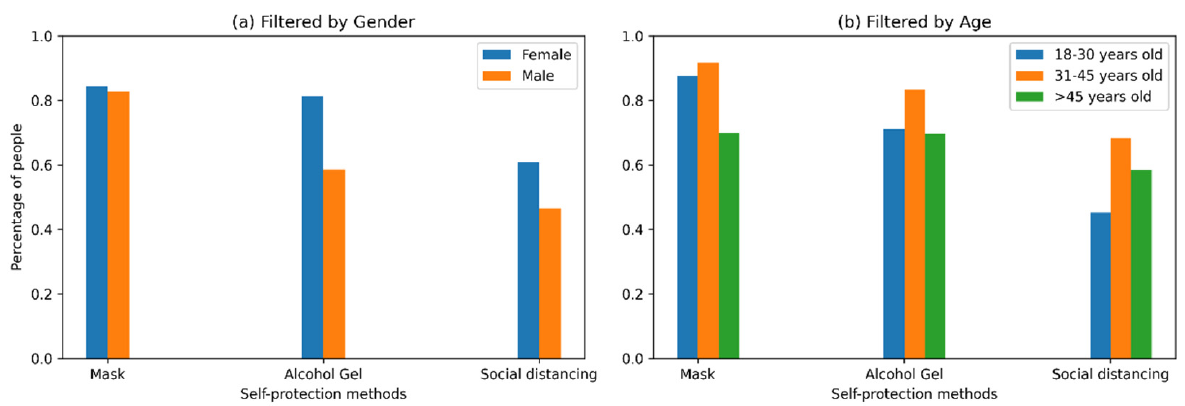
Figure 8. Self-protection methods by gender and age.